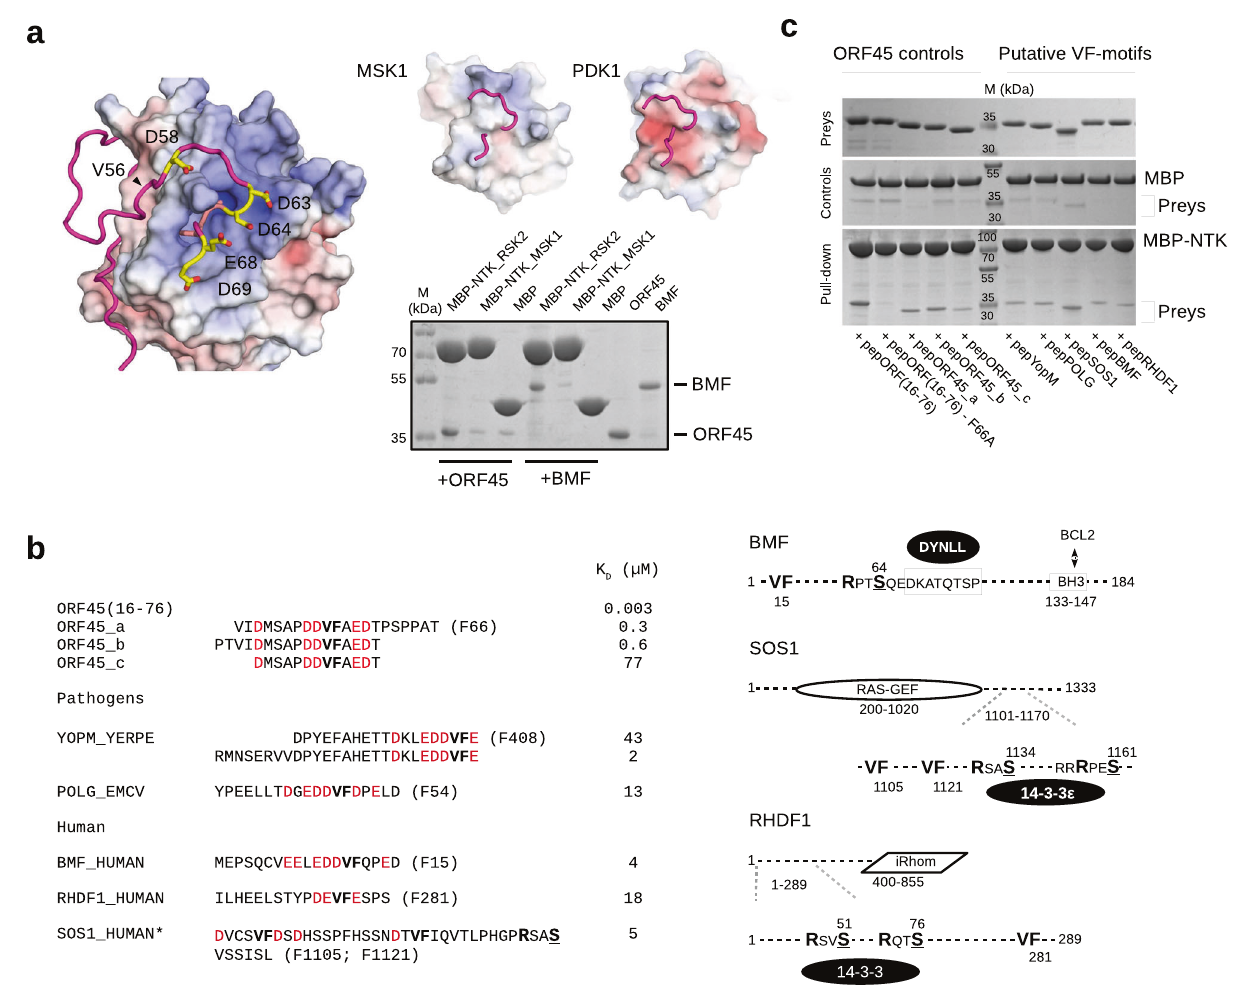
Fig. 7 VF-motifs from RSK signaling client proteins. a ORF45 VF-motif (in magenta) docks into a positively charged (blue) AGC kinase domain region via aspartates/glutamates (in yellow). The same surface area for a close RSK relative, MSK1 (PDB ID: 1VZO) 82 , and for the most distant AGC kinase relative, PDK1 (PDB ID: 4RRV) 83 , is also shown with the ORF45(56-69) region overlaid on the smaller panels at the right. (Blue: + 10 eV; Red: − 10 eV). The panel below shows the result of an MBP-pull down experiment where binding of GST-ORF45(16-76) and -BMF was tested with MBP-NTK_RSK2, -NTK_MSK1, and MBP as the control ( N = 1). The gel was stained with Coomassie protein dye. MBP: maltose binding protein. b Selected peptides with VF-motif-like sequences in disordered protein regions. The position of F in the full-length protein sequence (from Uniprot) is shown in brackets. Indicated protein fragments were produced as GST-fusions, puri fi ed and their binding af fi nity to the RSK2 NTK was measured by SPR. The panel on the left shows the schematic of the VF-motif containing human full-length proteins: disordered protein regions are shown as a dashed line and the relative position of VF- motifs and K/RxxS/T phosphorylation sites are indicated. (In BMF, the dynein light chain binding motif is indicated and boxed, BH3 – BCL2 binding region; SOS1 has a Ras GDP exchange factor domain, RAS-GEF; RHDF1, has an inactive rhomboid protease domain, iRhom.) Phosphorylation sensitive interacting partners are shown with black ellipsoids: DYNLL, dynein light chain binding affects cellular BMF localization; for SOS1, 14-3-3 protein binding affects cellular localization and EGF receptor adapter binding; for RHDF1/2, 14-3-3 binding affects TNF α converting enzyme (TACE) activity and ultimately cell surface receptor shredding. c MBP pull-downs with puri fi ed GST-fusion constructs containing VF-motif peptides (preys) from ORF45, YopM, POLG, SOS1, BMF, and RHDF1 (see Panel b ). The gel was stained with Coomassie protein dye. Maltose resin was loaded with MBP-NTK or MBP only, where the latter was used to asses unspeci fi c binding of the preys ( N = 1). Source data are provided as Source data fi